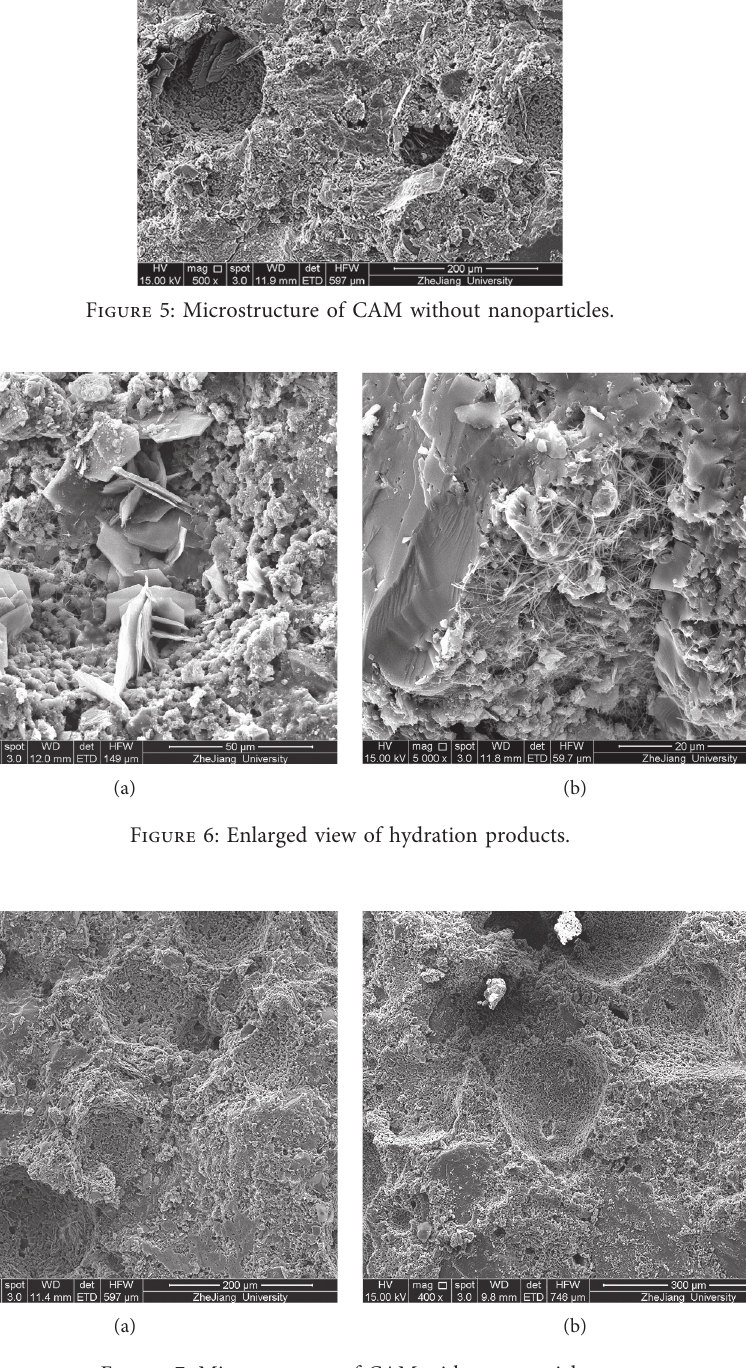
Figure 7: Microstructure of CAM with